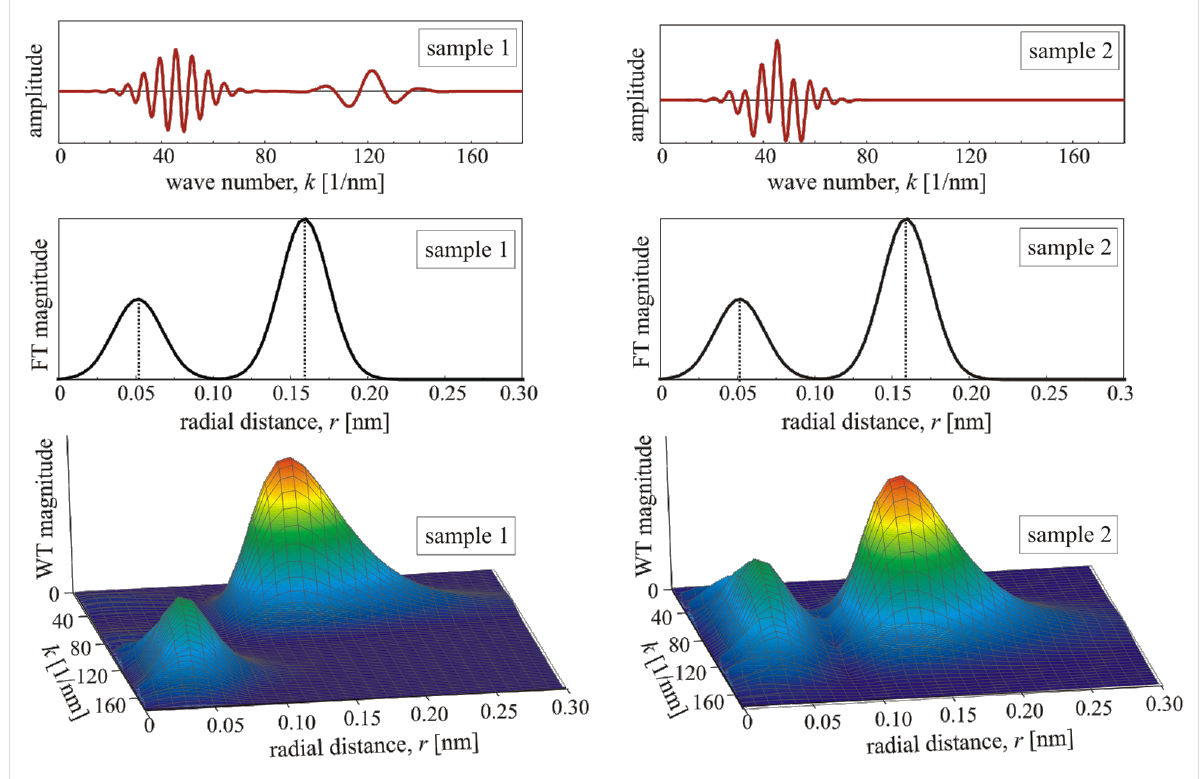
Figure 4: Two different sample signals (upper panel) that show the same radial distance function after FT (centre), but clearly different WT signals (lower panel).